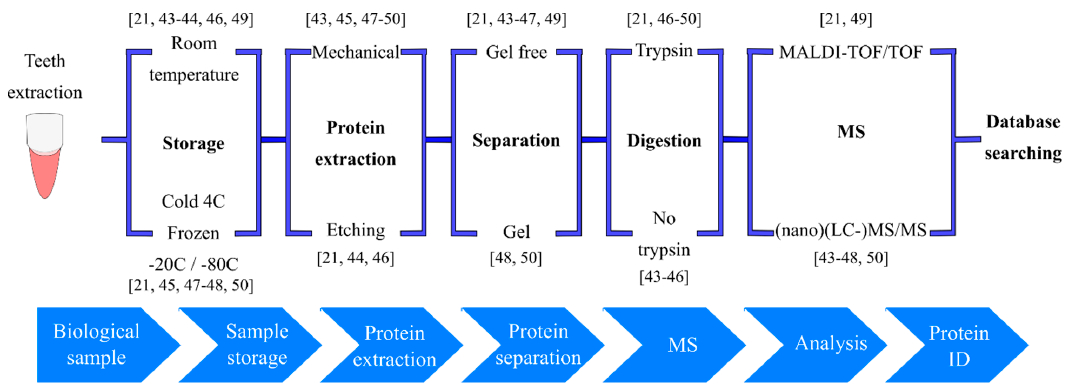
Figure 2. Strategies for proteomic analyses of tooth enamel. Schematic of treatment steps used to characterize proteins in human tooth enamel from archeological, modern and teeth affected by molar hypomineralization (chalky tooth enamel). Porto et al. [21]; Lugli et al. [43]; Stewart et al. [44];